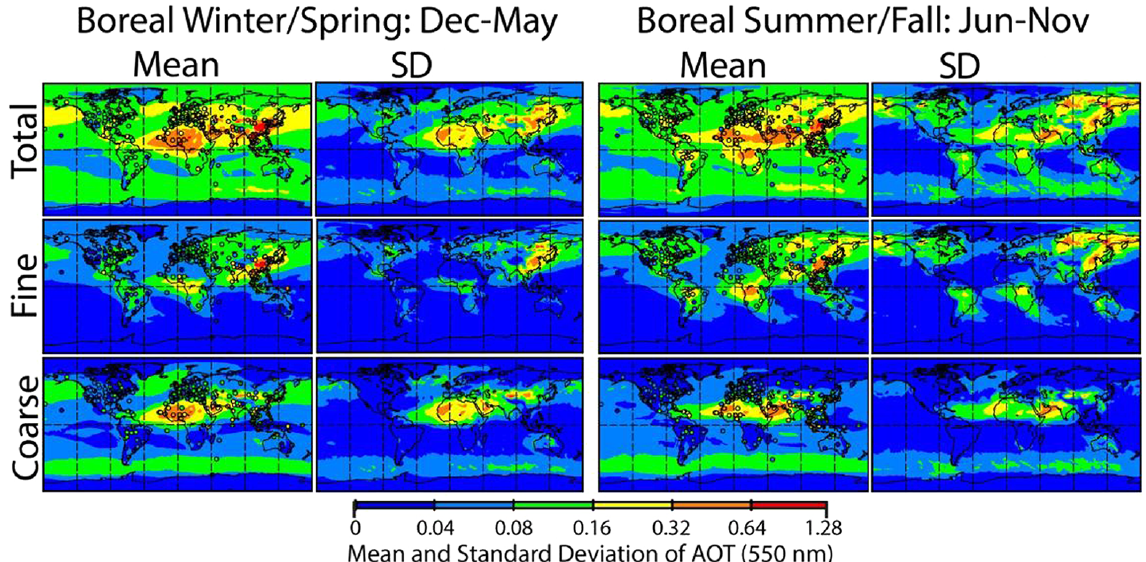
Figure 3. Mean and standard deviation of the ICAP-MME 550nmAOT ensemble consensus for the December 2011–November 2012 time period. Included are the four core models of ECMWF MACC, FNMOC/NRL NAAPS, JMA MASINGAR, and NASA GMAO GEOS-5. Breakout is by boreal winter–spring (December–May) and summer–fall (June–November). Further striations are for total, fine and coarse mode optical depth. Provided in dots are the AERONET means for the same time period, although these are not pairwise with the model